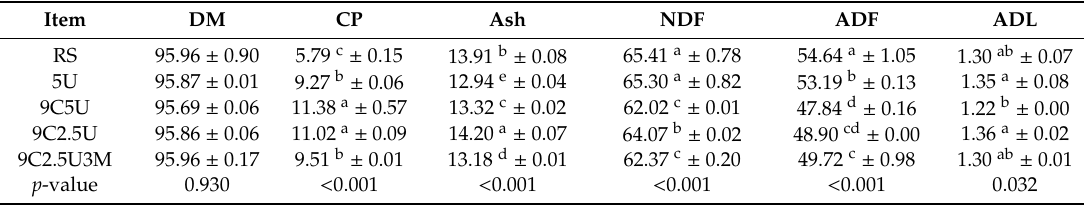
Table 3. E ff ect of ammoniation treatment on the chemical composition of rice straw (%) after 60 days of